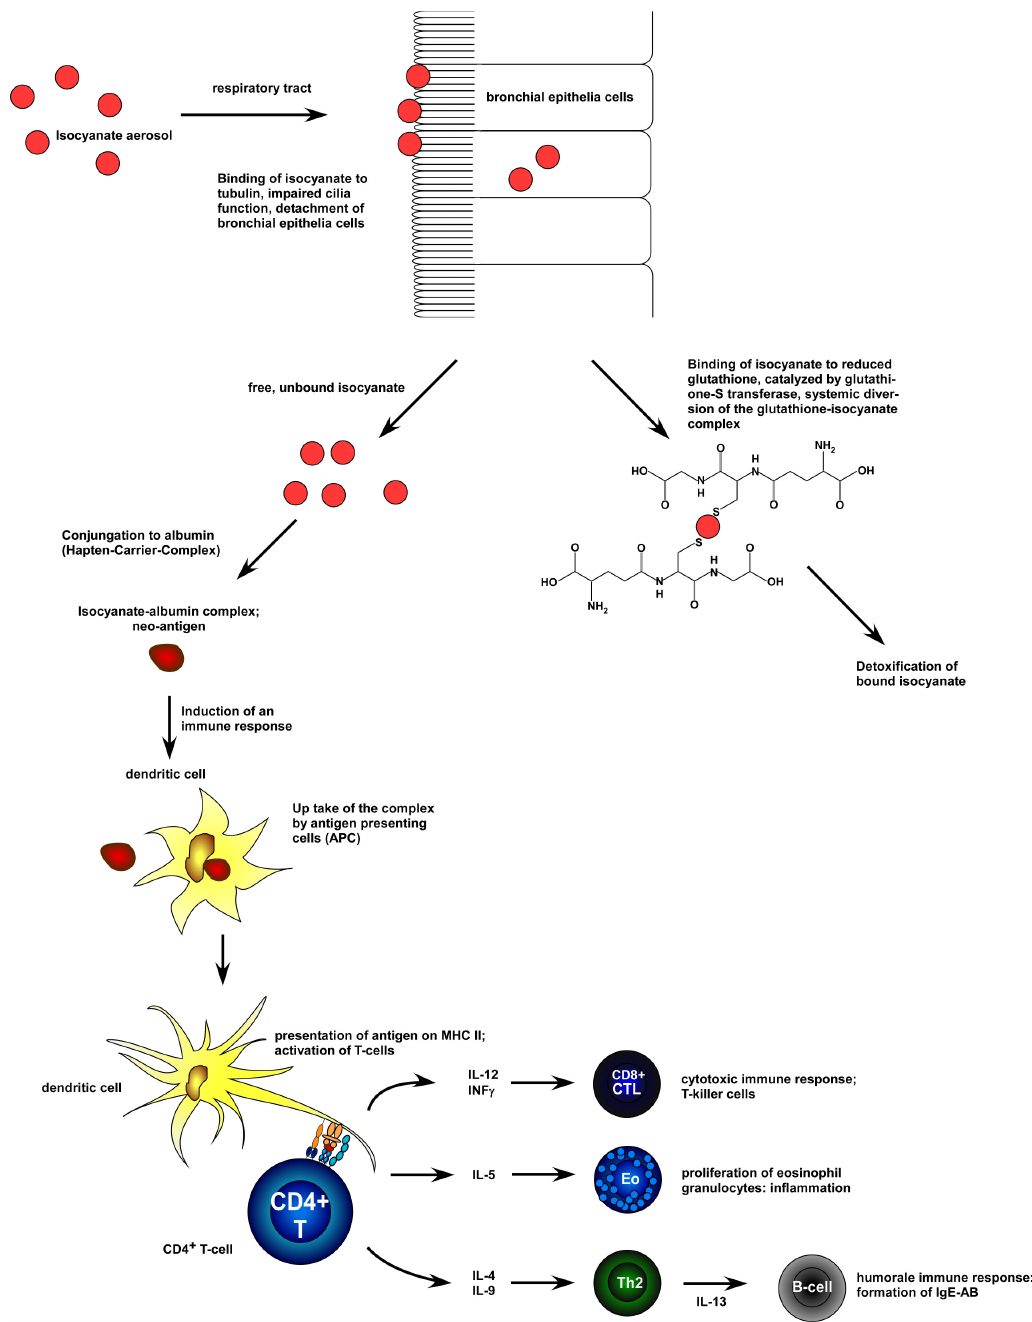
Figure 1. Predicted mechanism for the effects of isocyanate in the development of isocyanate induced asthma. The inhaled isocyanate or its derivates are absorbed by the bronchial epithelia cells, i.e. , by binding to tubulin. This results in a local disturbance and impairment of cilia function or a detachment of bronchial epithelia cells. Glutathione S transferase mediates the detoxification process. If the capacity of GSH is exhausted, the free isocyanate can bind to e.g., albumin. This isocyanate-albumin-complex acts as a neo-epitope, that is recognized by the immune system, and is leading to an induction of an immunological process by activation of CD4+ cells. The following inflammation process and, under certain circumstances, an additional induction of IgE antibodies induce the hypersensitivity